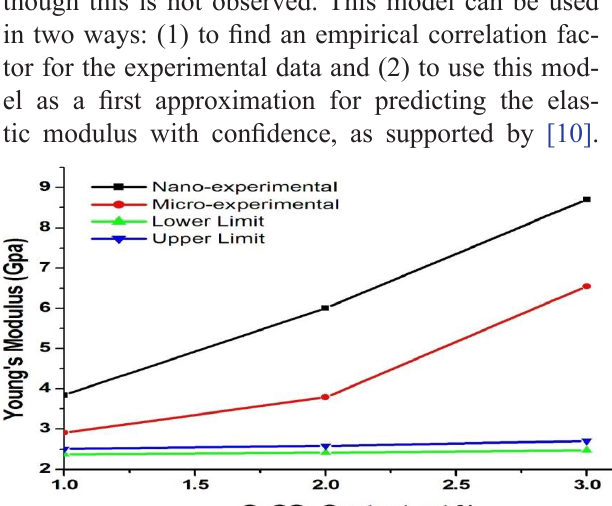
Fig. 10. Comparison of predicted Young’s modulus from the mix- tures rule to experimental data: micro- and